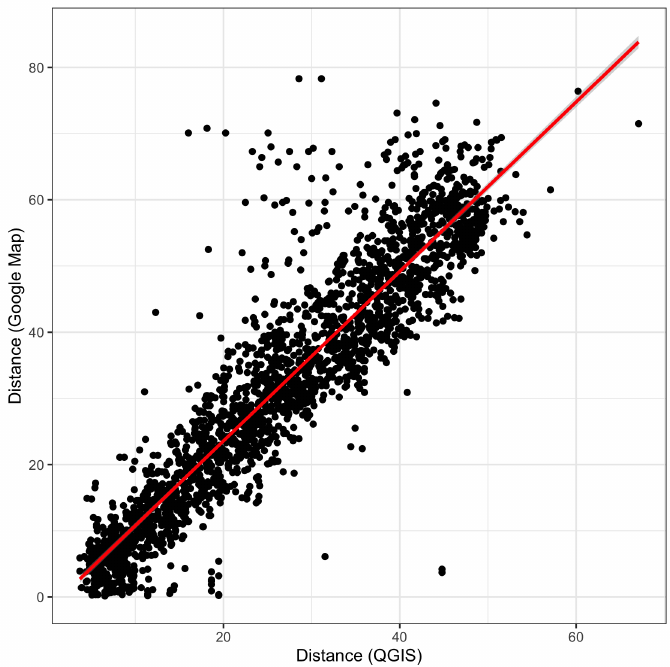
Figure 3. Scatterplot between distance measure generated using Google Maps and